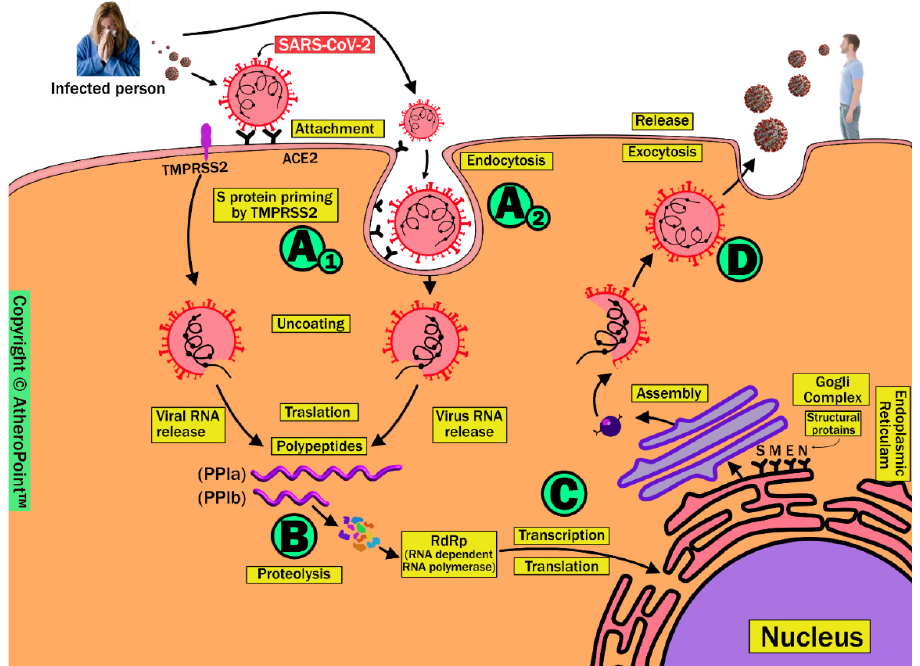
Figure 2. Replication of SARS ‐ CoV ‐ 2 in four phases. (Original image, AtheroPoint™ LLC, Roseville, CA,